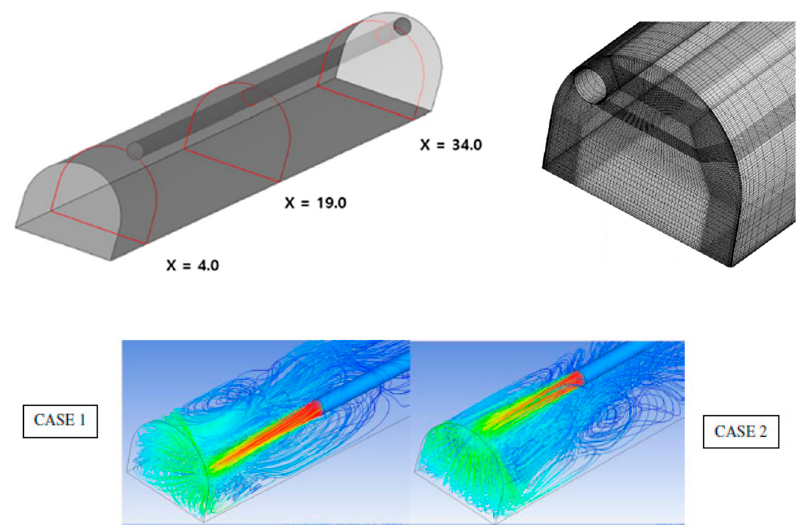
Figure 7. Geometry, computational grid, and airflow streamlines [29]. (Adapted with permission from ref. [29]. Copyright 2016 Taylor & Francis Group).